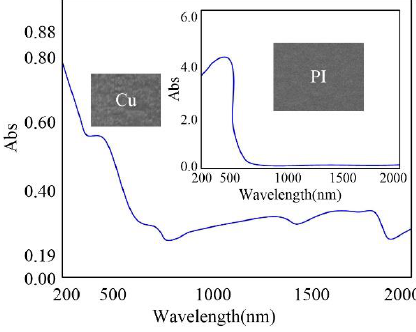
Figure 4. Absorptions of FPC materials.